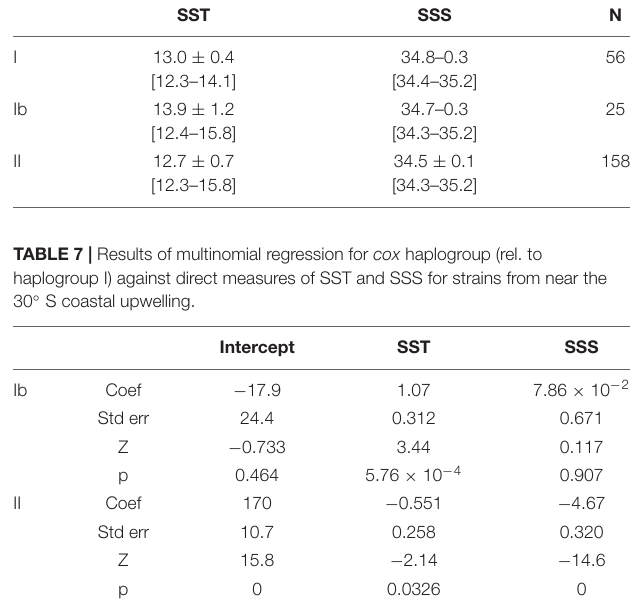
TABLE 6 | Mean SST and SSS for strains in each cox haplogroup originating exclusively from the upwelling center near 30 ◦ S. SST